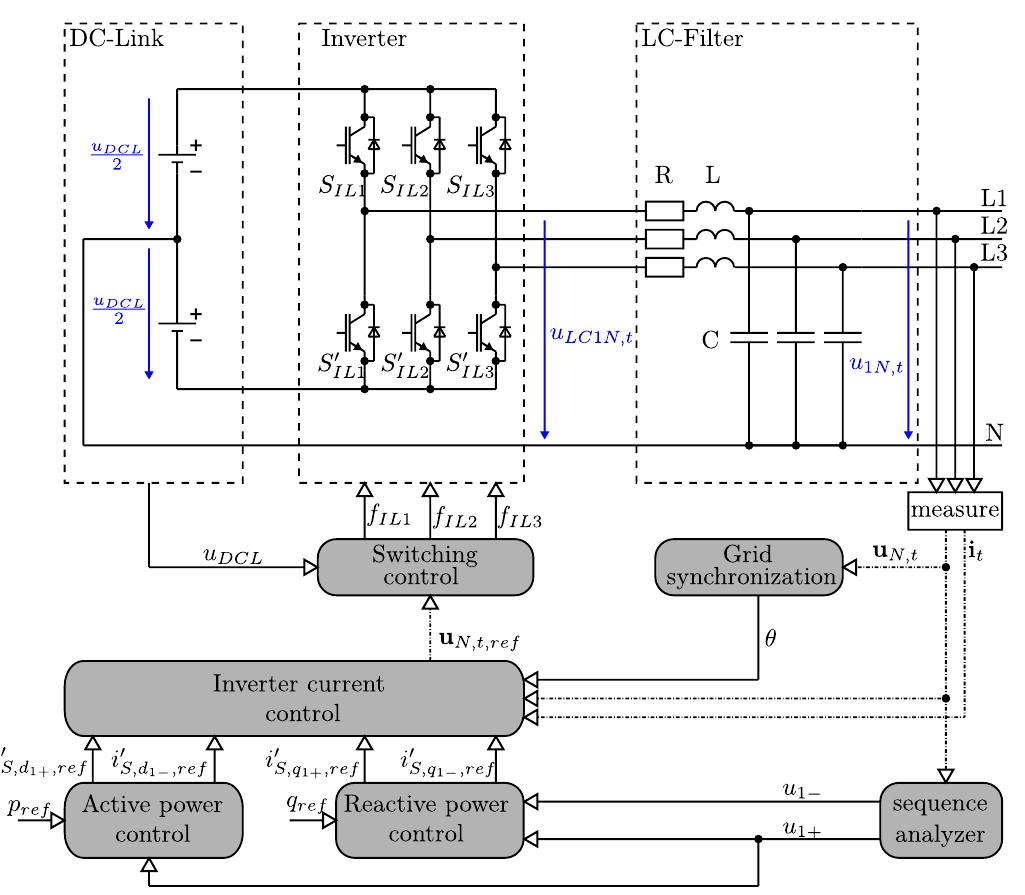
Figure 3. Converter and its control routines used in the simulation